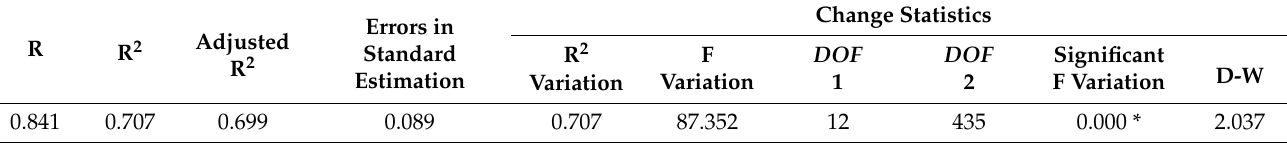
Table 5. Bottom-up model summary.